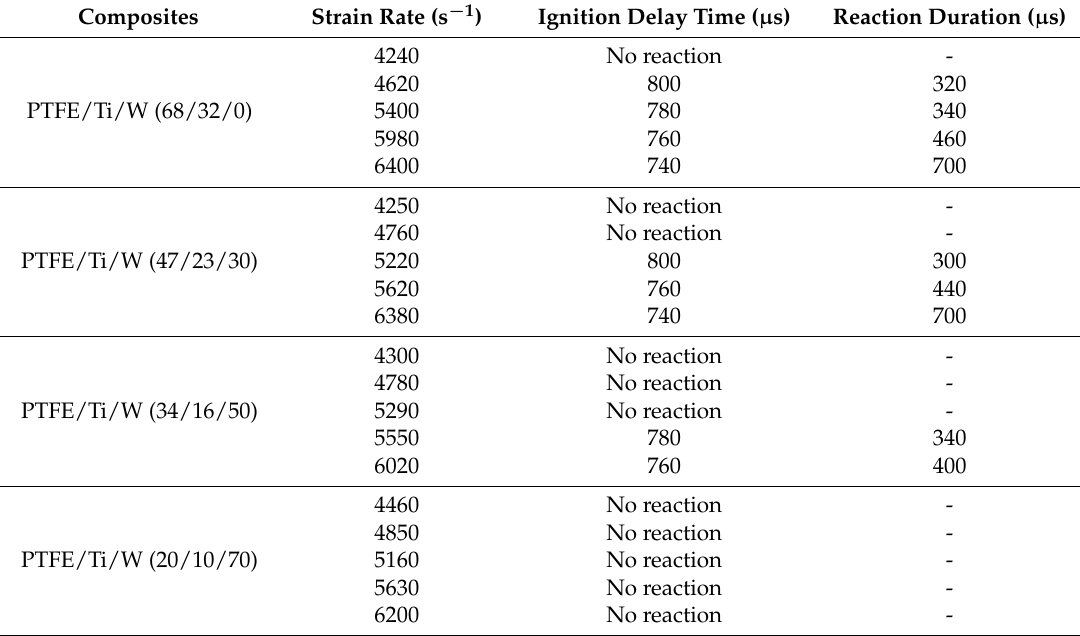
Table 3. Ignition delay time and reaction duration of PTFE/Ti/W composites.